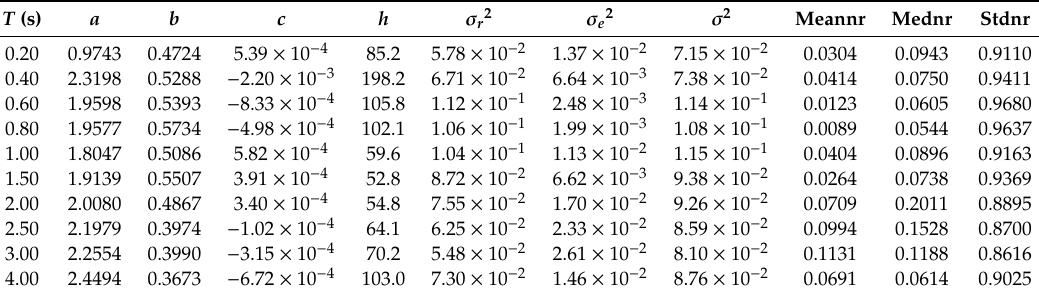
Table A1. Coe ffi cients of the GMPE for set 1, Equation (1), ground type B